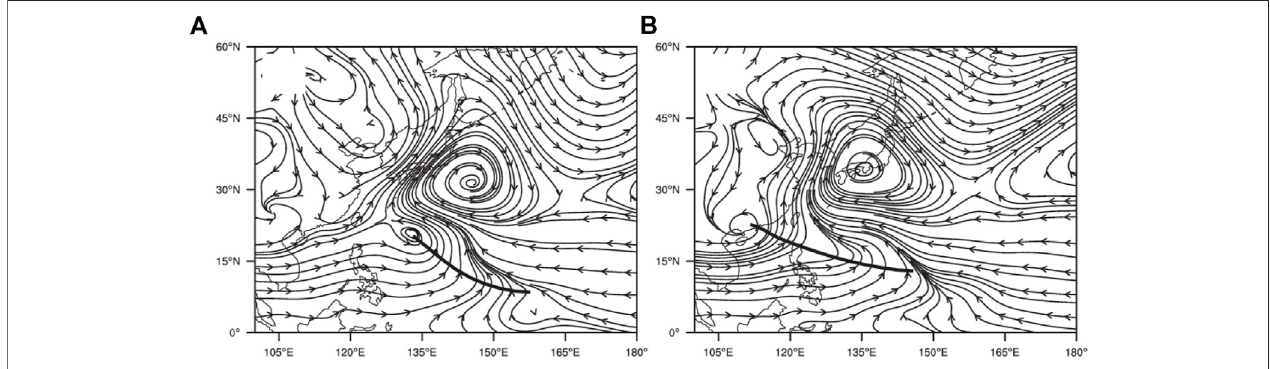
FIGURE 8 | Composite of 850 hPa fl ow fi eld on the genesis day of the two types of TCs (m/s): (A) eastern-track type; (B) turning type.